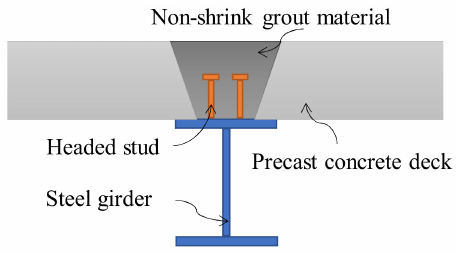
Figure 1. Steel and concrete composite beam with precast